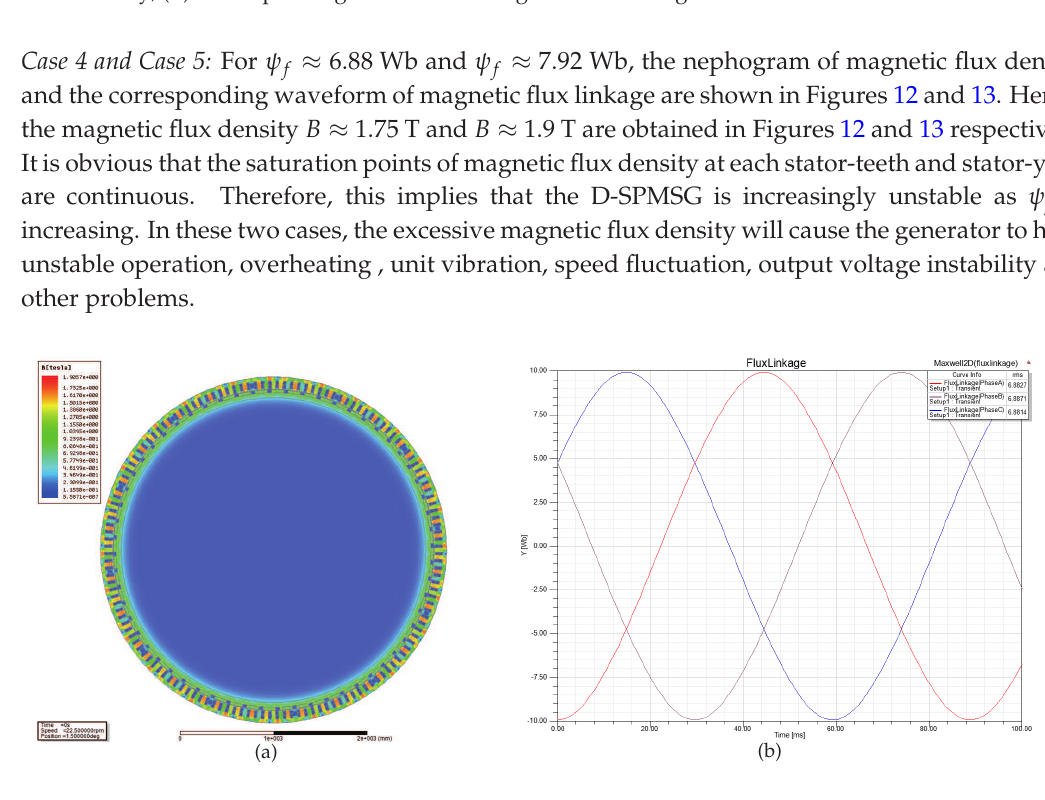
Figure 11. Results of finite element analysis with ψ f ≈ 5.16 Wb in Case 3 : ( a ) Nephogram of magnetic flux density; ( b ) Corresponding waveform of magnetic flux linkage.